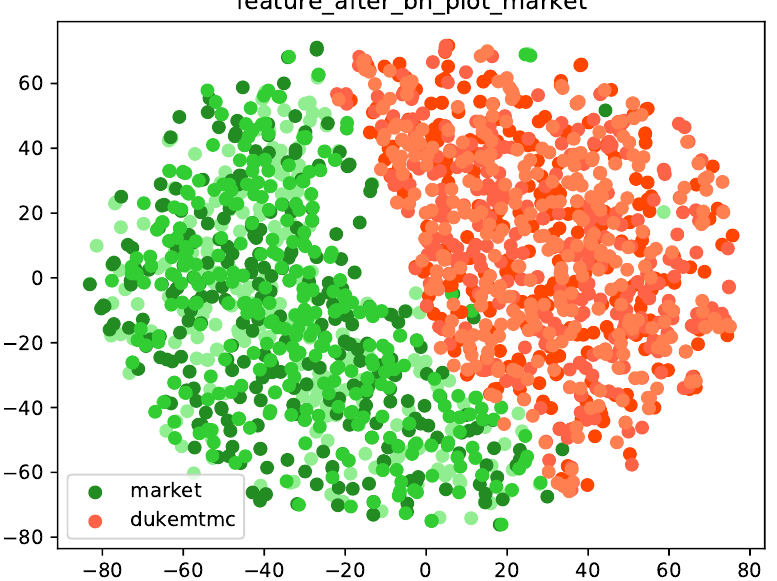
Figure 1. Illustration of the features of Market1501 and DukeMTMC-reID datasets. The green dots represent the feature distributions of Market1501 dataset, whereas the red ones represent the feature distributions of DukeMTMC-reID dataset.